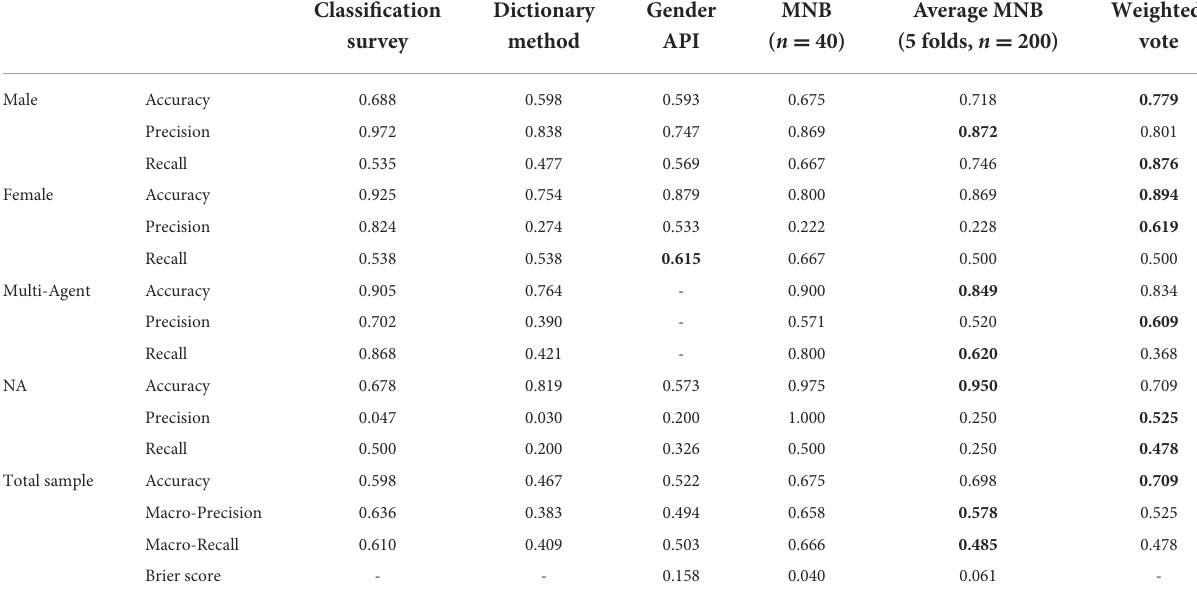
TABLE 2 Accuracy, precision and recall of classification